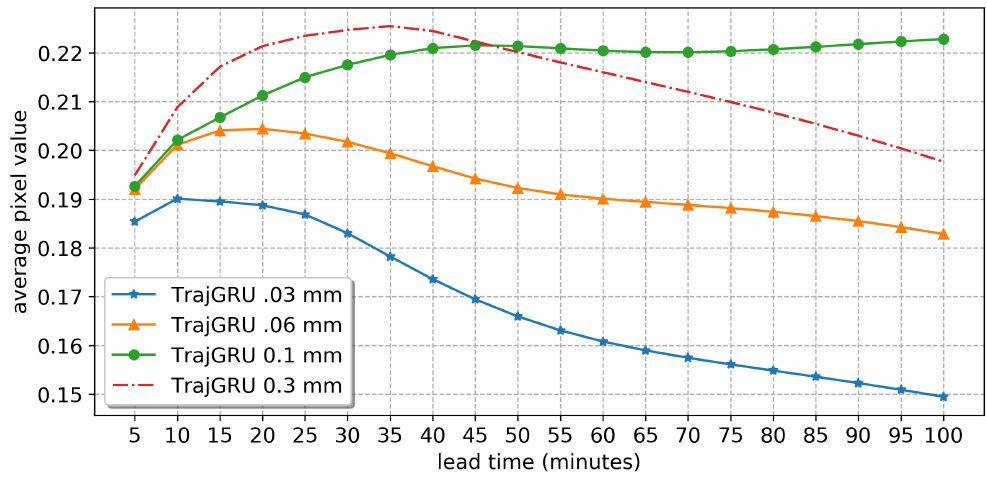
Figure 4. Average pixel values (normalized dBZ) of the predictions generated by the 4 models on the test set. When progressively raising the rainfall threshold in the loss, the resulting models progressively increase the total amount of predicted